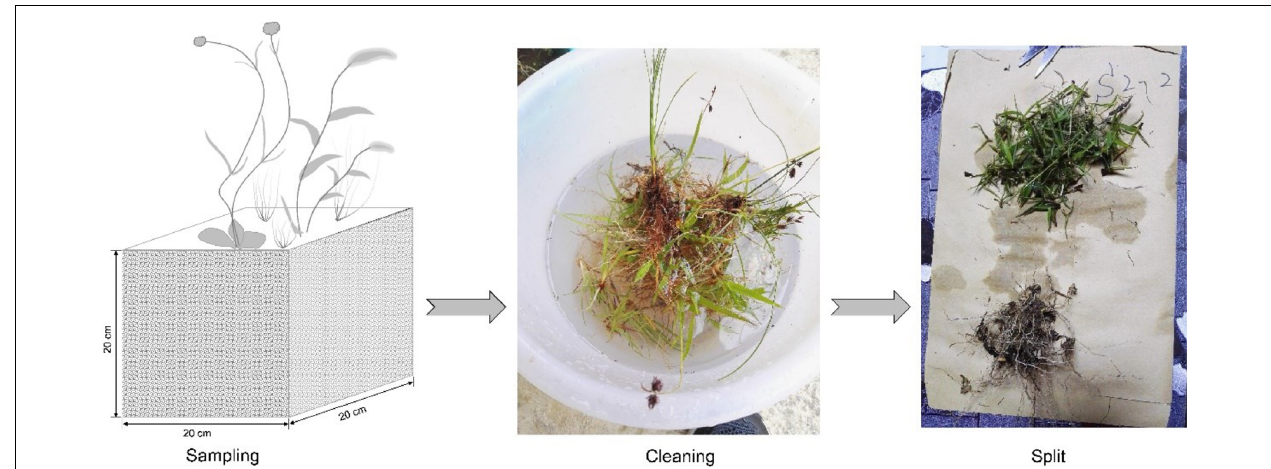
FIGURE 2 | Collection of root and shoot